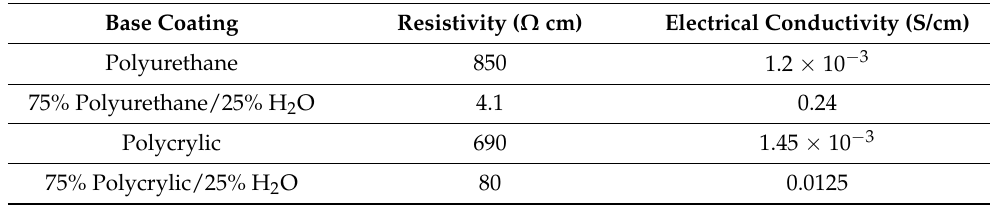
Table 4. Summary of MD simulations of thermal conductivity values at room temperature for the maximum length and di ff erent diameters.